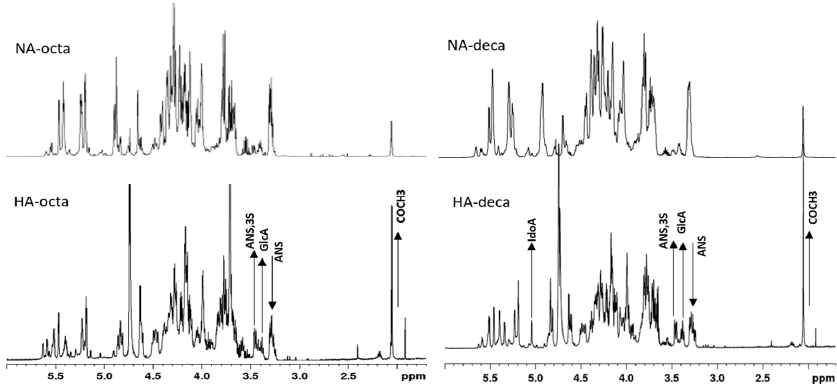
Figure 5. 1 H-NMR spectra of HA and NA components of octa and decasaccharide fractions. The direction of arrows, up or down, indicates the increase or decrease respectively of some characteristic signals in spectra of HA components.